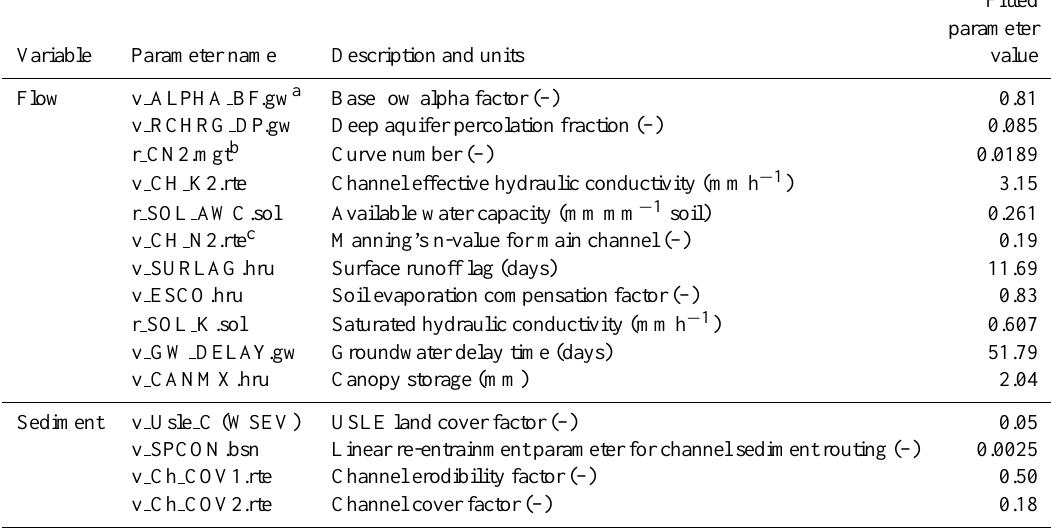
Table 4. Calibrated values of adjusted parameters.